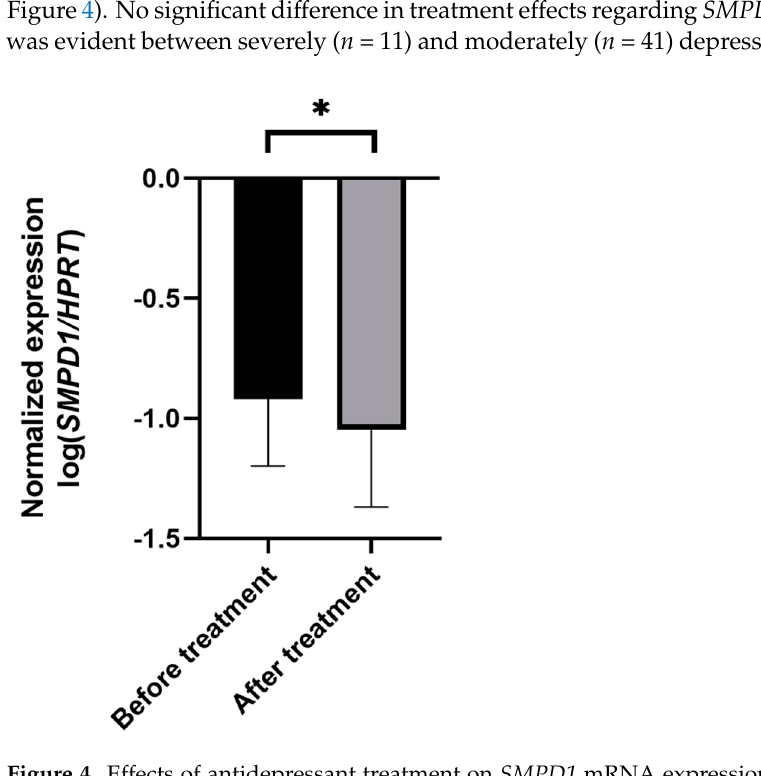
Figure 4. Effects of antidepressant treatment on SMPD1 mRNA expression. Unmedicated MDD patients displayed significantly higher SMPD1 mRNA expression before treatment as compared with after treatment. Data represent the mean and SD. * p < 0.05.